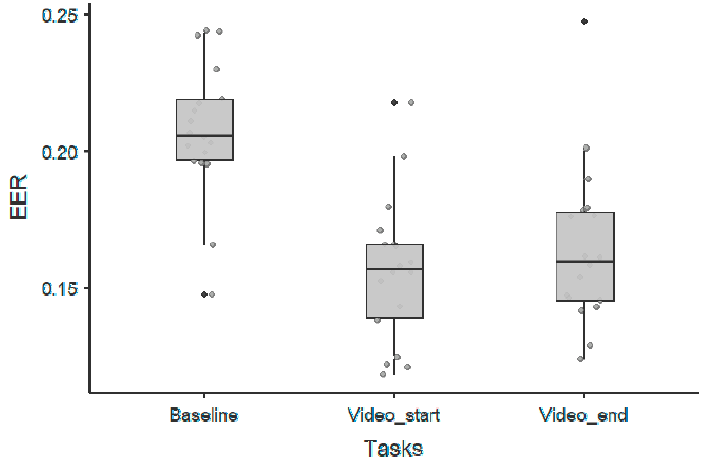
Figure 3. Scatter-plots represent the EERs for each experimental condition for the exponent parameter. Table 2. Statistical analysis for the 1/f exponent parameter.